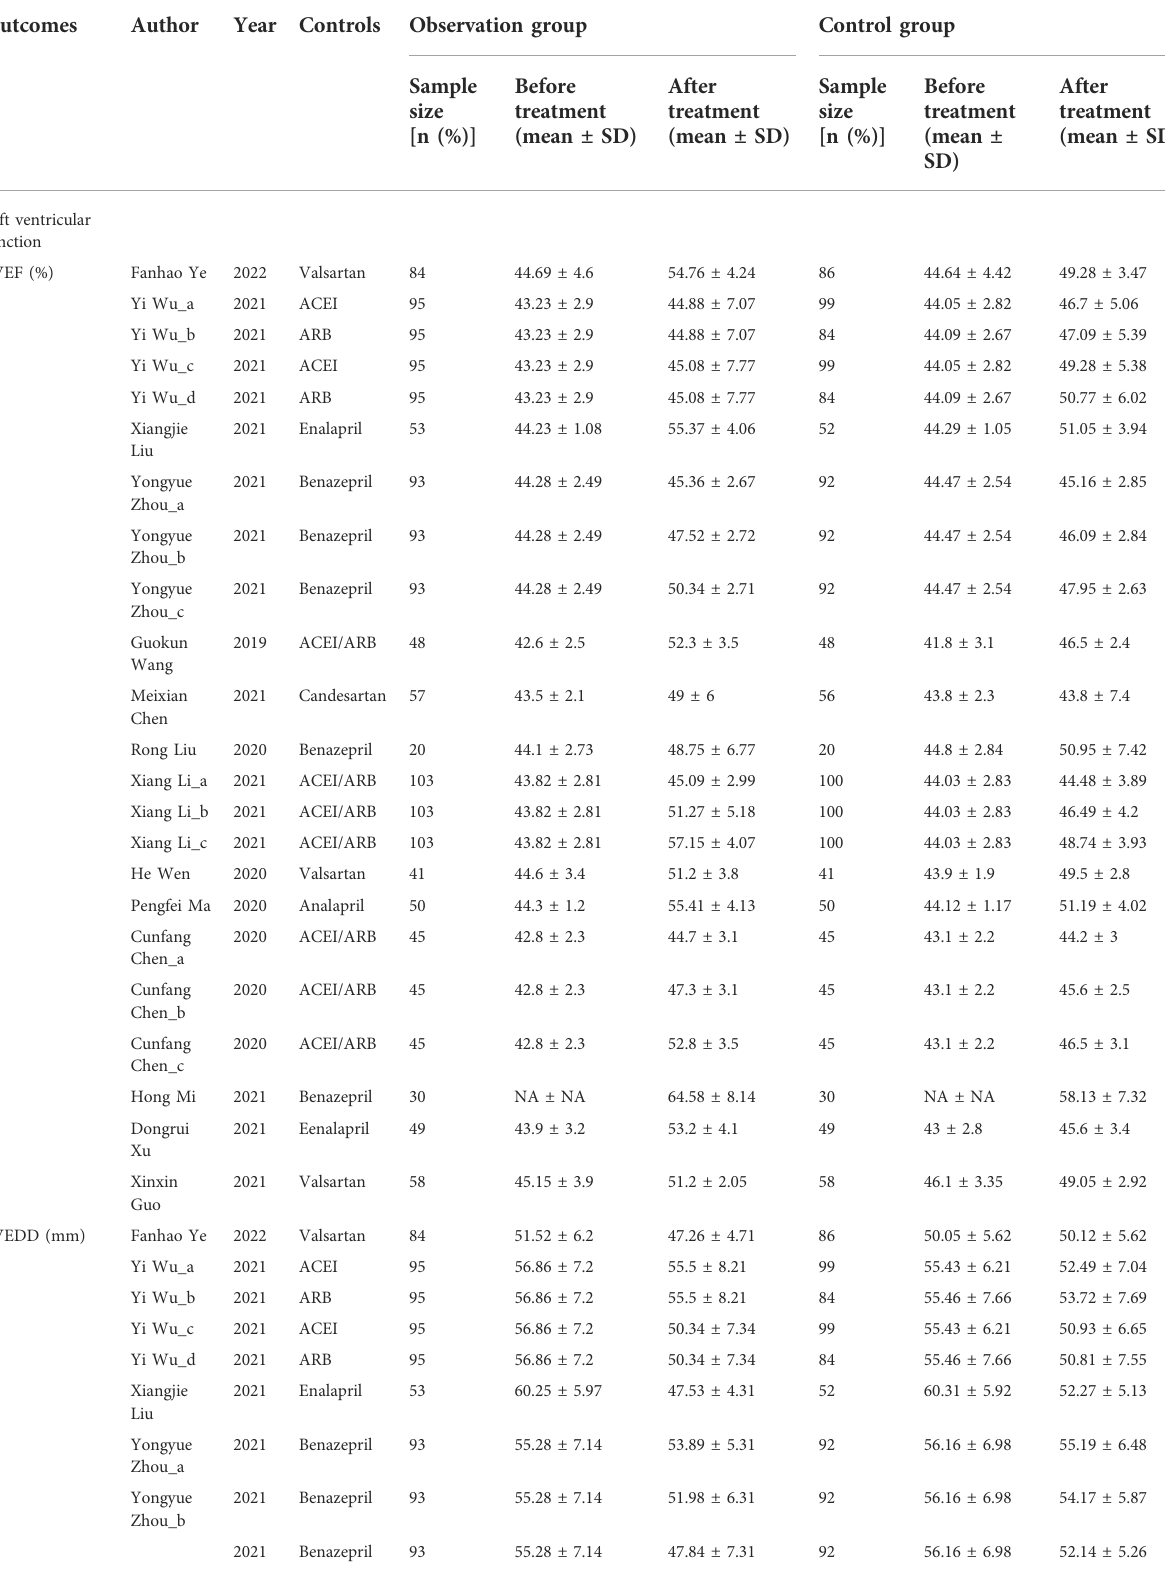
TABLE 2 Left ventricular function outcomes before and after treatment between sacubitril-valsartan and ACEI/ARB group. Outcomes